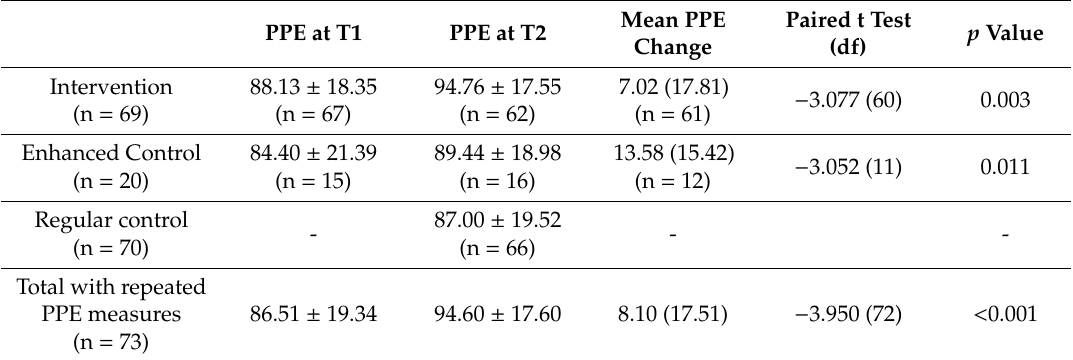
Table 2. Mean Parental Perceptions of Exposure at T1 (study beginning) and T2 (study end) by study groups.